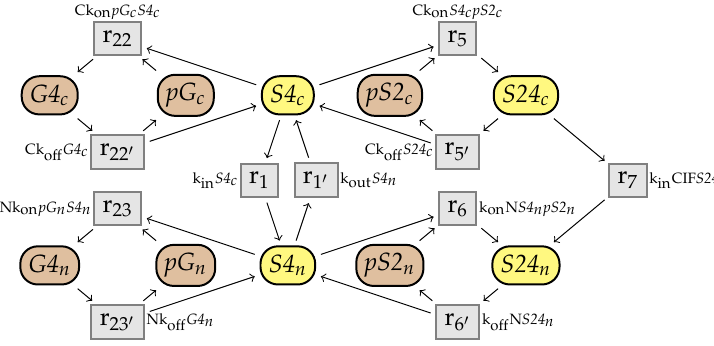
Figure 24. Sub-network W of the Smad -based signal transduction model from